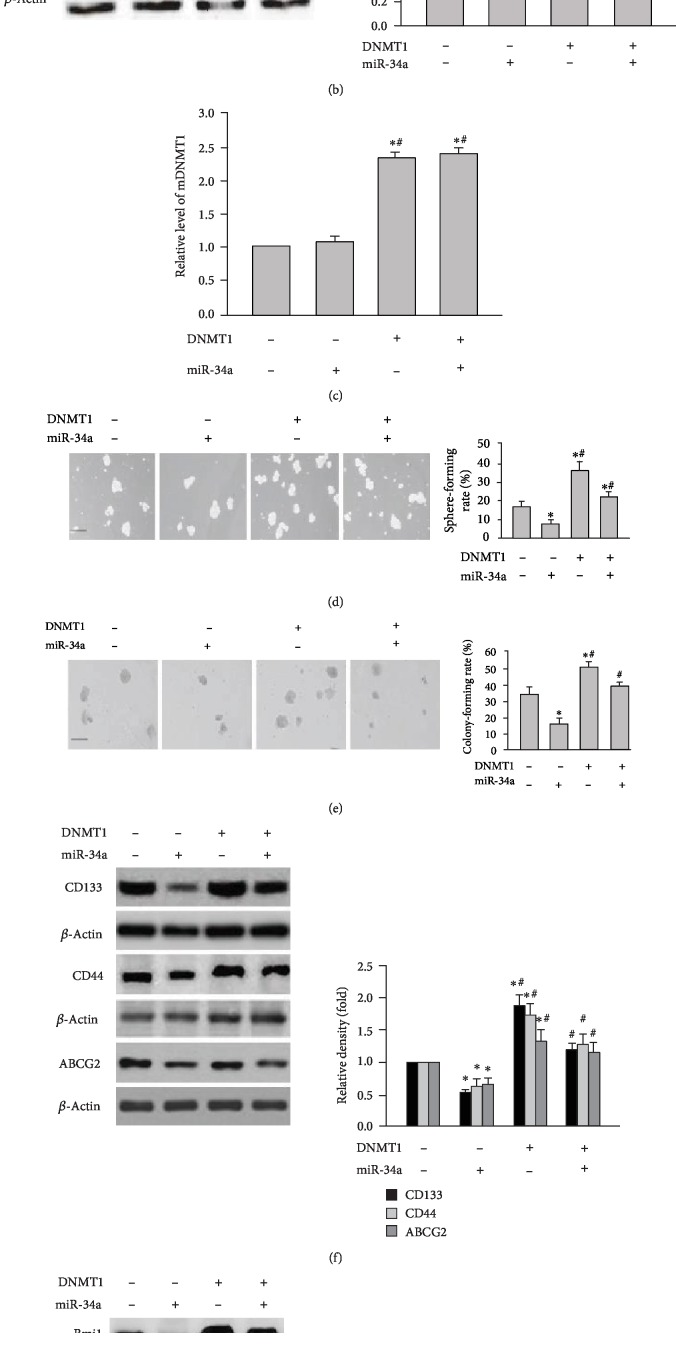
Effects of overexpressing DNMT1 combined with the miR-34a-5p mimic on stemness in U2OS cells. (a) qRT-PCR analyzed the effect of the miR-34a mimic on the miR-34a expression in U2OS cells overexpressing DNMT1. (b, c) Immunoblotting and qRT-PCR detected the DNMT1 protein and mRNA in U2OS cells overexpressing DNMT1 (DNMT1) transfected with the miR-34a mimic (miR-34a) and their densitometric analysis (right), with β-actin serving as a loading control. ∗p < 0.05 (n = 3) vs. U2OS cells; #p < 0.05 (n = 3) vs. U2OS cells transfected with miR-34a. (d) Representative images of the spheres of U2OS cells overexpressing DNMT1 transfected with miR-34a (left) (scale bar, 200 μm) and the sphere-forming rates (right). (e) Representative images of the colonies of U2OS cells overexpressing DNMT1 transfected with miR-34a (left) (scale bar, 200 μm) and the colony-forming rates (right). (f) CD133, CD44, and ABCG2 proteins of U2OS cells overexpressing DNMT1 transfected with miR-34a (left) and their densitometric analysis (right). (g) Bmi1, Sox2, and Oct4 of U2OS cells overexpressing DNMT1 transfected with miR-34a. ∗p < 0.05 (n = 3) vs. U2OS cells; #p < 0.05 (n = 3) vs. U2OS cells transfected with miR-34a.